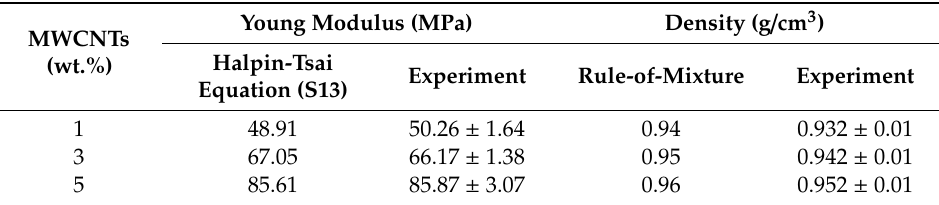
Table 4. Predicted elastic modulus and density for EVA / MWCNT